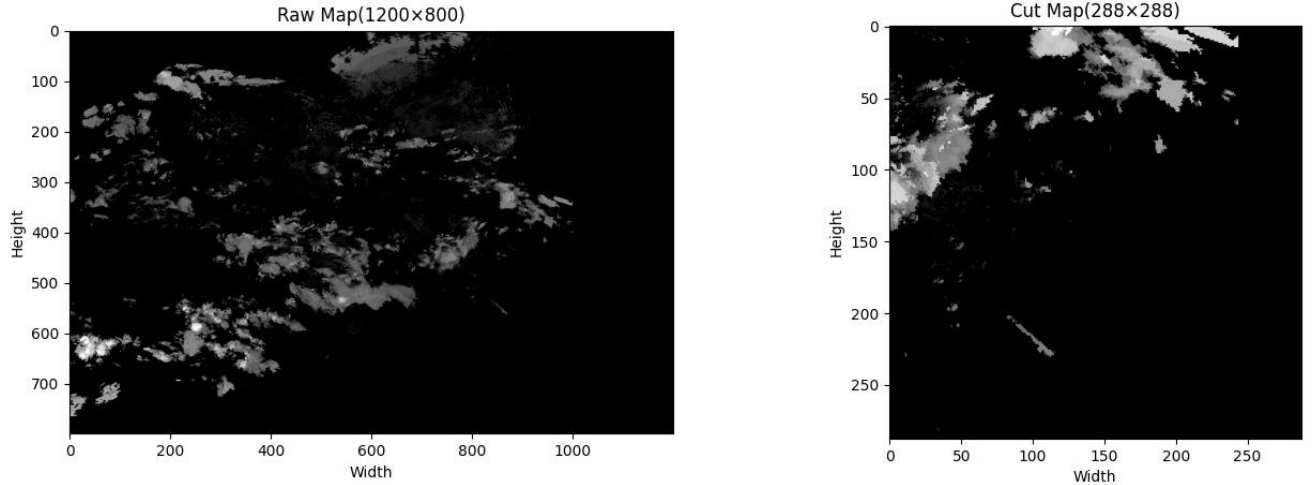
Figure 7. The relationship between grid size selection and the amount of data eligible for rainfall enhancement.